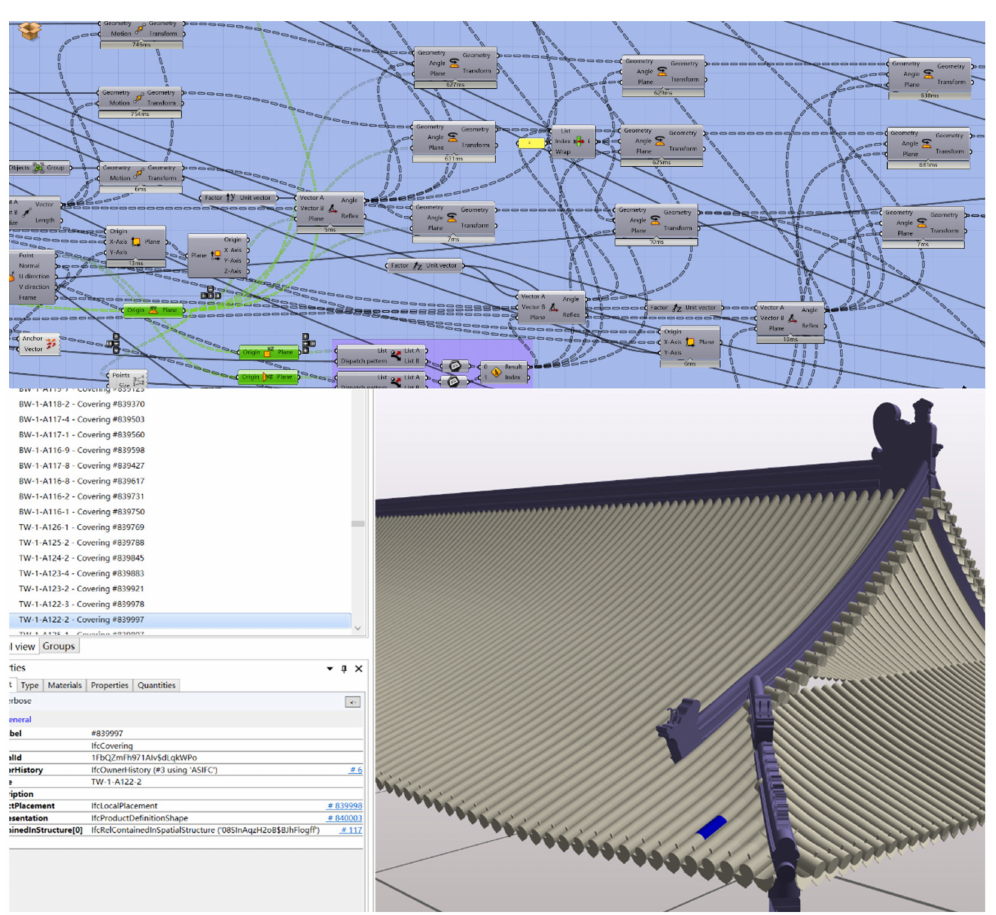
Figure 22. The roof tile generators and the IFC model of Block Instance with serial numbers (tile named TW-1-A122-2 was